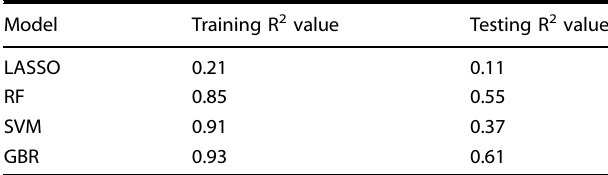
Table 2. The training and testing R 2 values obtained from the various